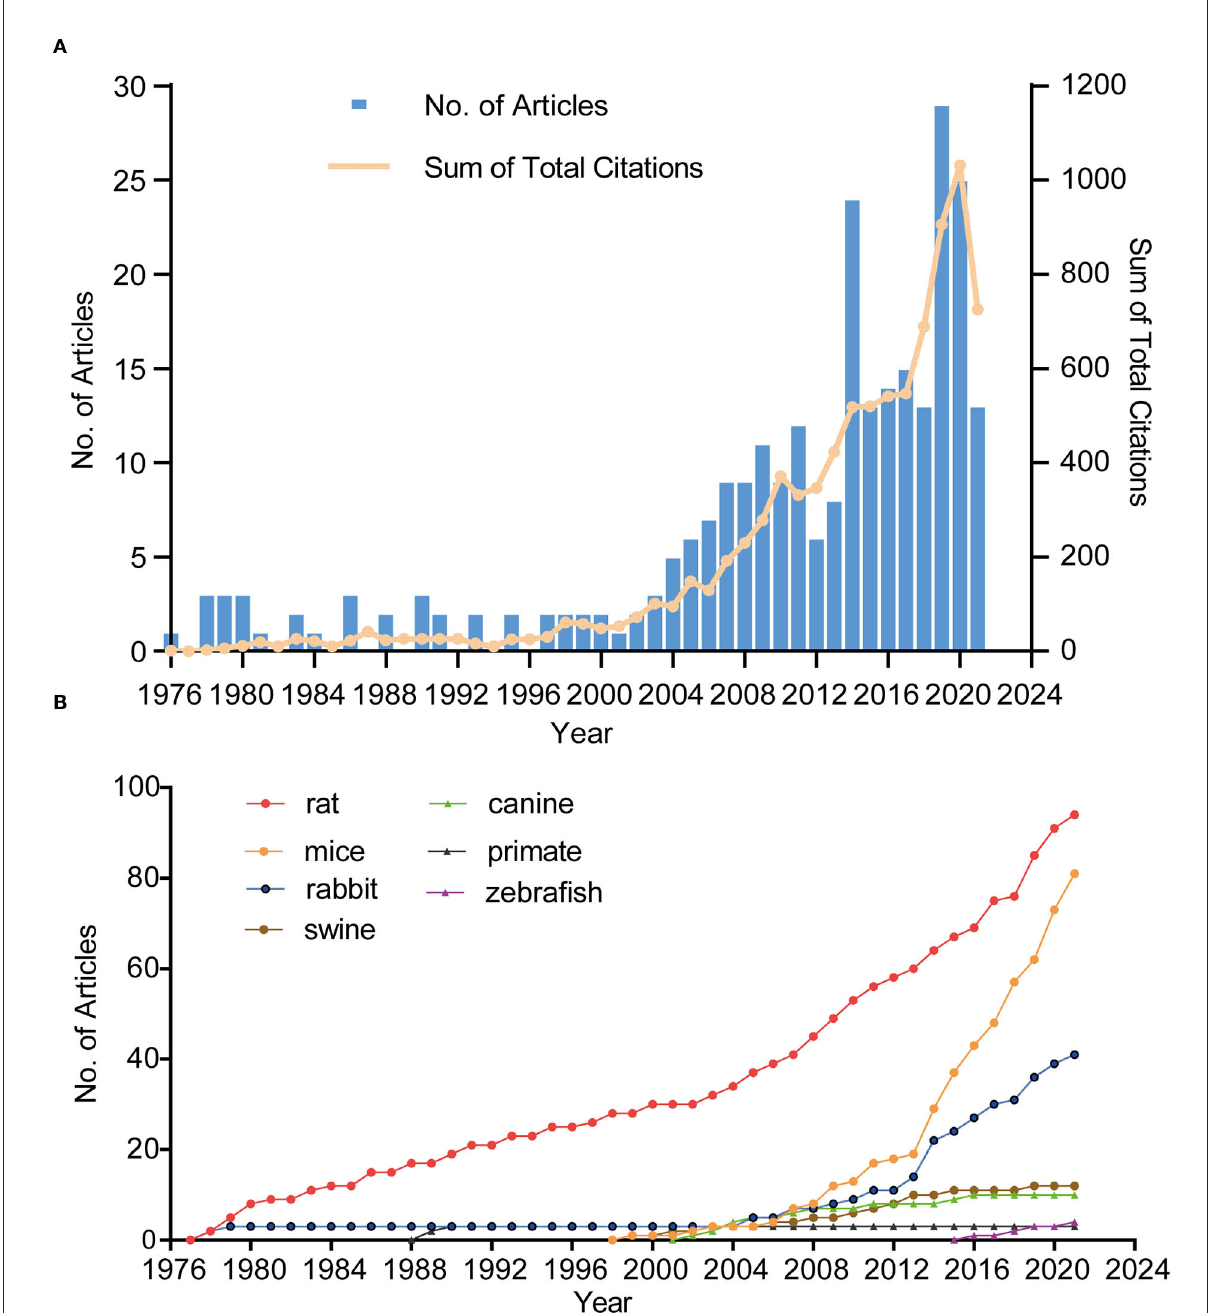
FIGURE2 The trend in terms of publications, citations (A) , and different species (B) . Blue bars represent the number of articles related to animal IA model per year. The yellow line represents the trend of total citations in this